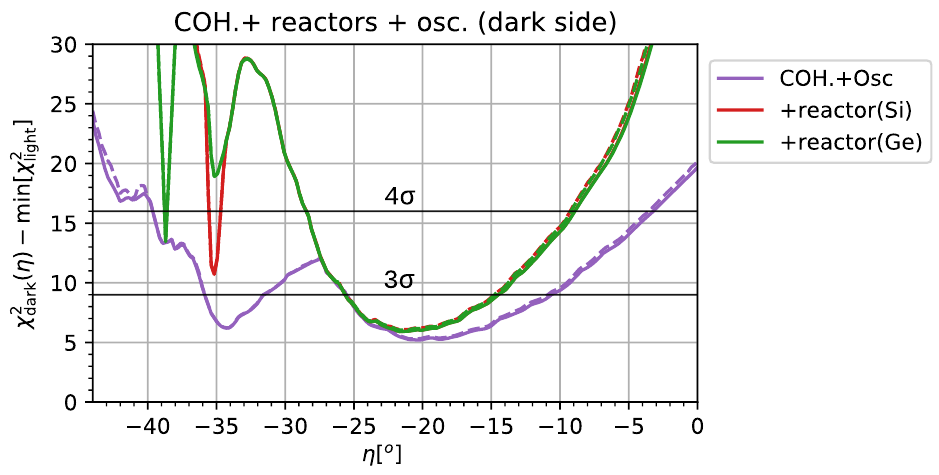
Figure 8 . Sensitivity to exclude the LMA-dark solution by a hypothetical CE ν NS measurement at a nuclear reactor using a Si (red curves) or a Ge (green curves) target. In both cases we assume a 5% measurement of Q SM . For dashed curves off-diagonal (cid:15) η are fixed to zero, for solid curves αβ we minimize with respect to them. For η & − 33 ◦ the Si and Ge curves overlap.